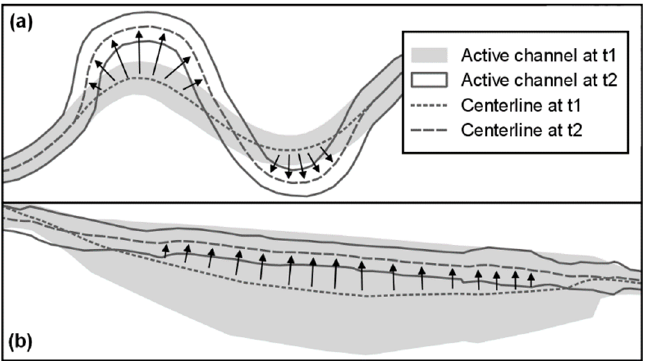
Figure 11. Active-channel planform migration in ( a ) stable and ( b ) changing active-channel width conditions, referring to the period t1-t2. Black arrows indicate the active-channel centerline horizontal displacement.